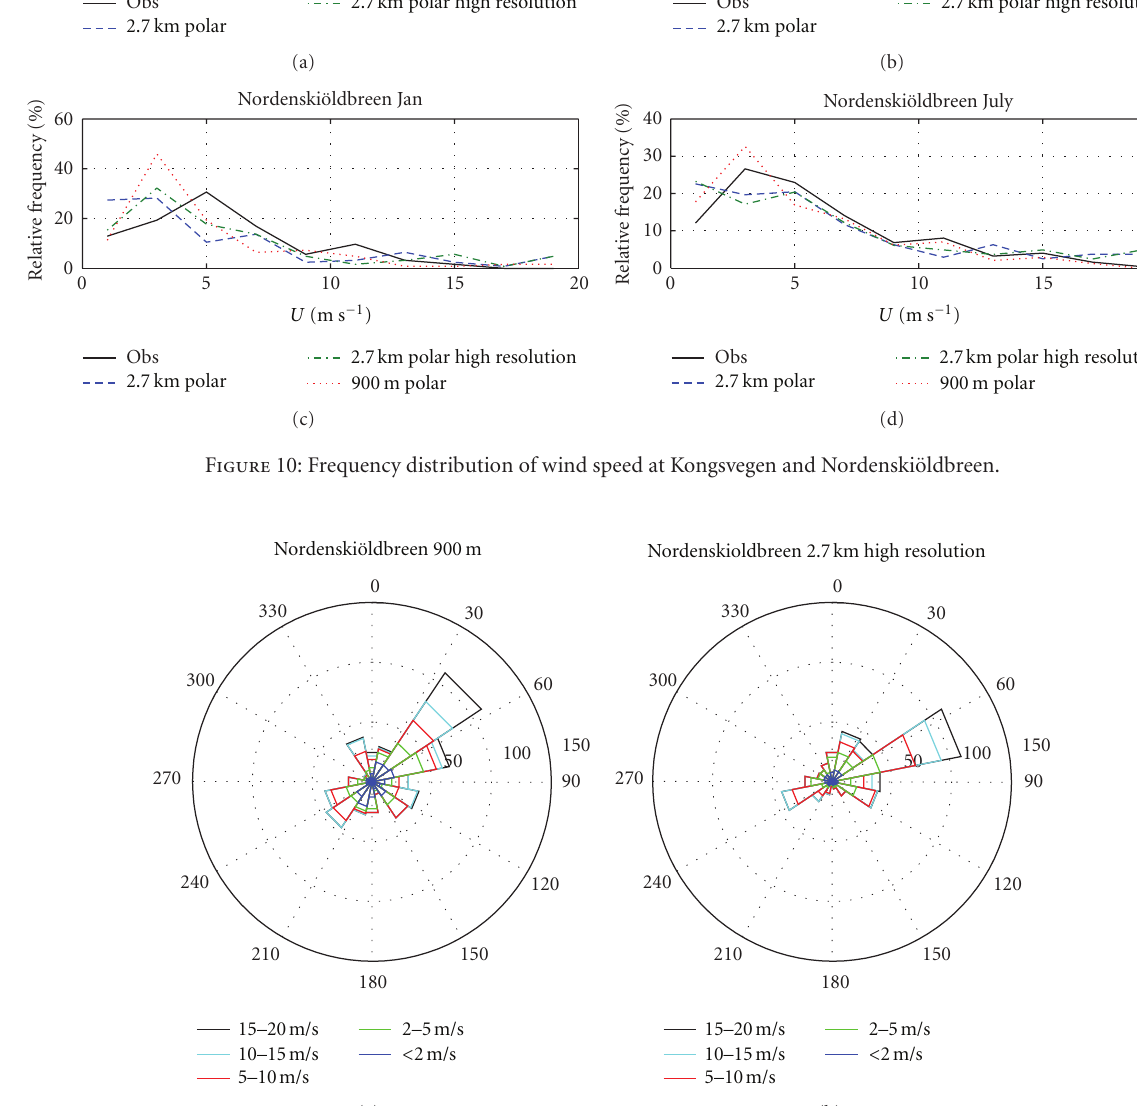
Re-Analysis), and two PBL/surface layer schemes, QNSE (developed for very stable conditions) and MYNN2.5 (with turbulence interaction with clouds). Additional simulations were performed for July 2009 and January 2010 considering higher vertical resolution in the lowest 1.5 km and 900 m horizontal resolution, respectively. The investigation focuses